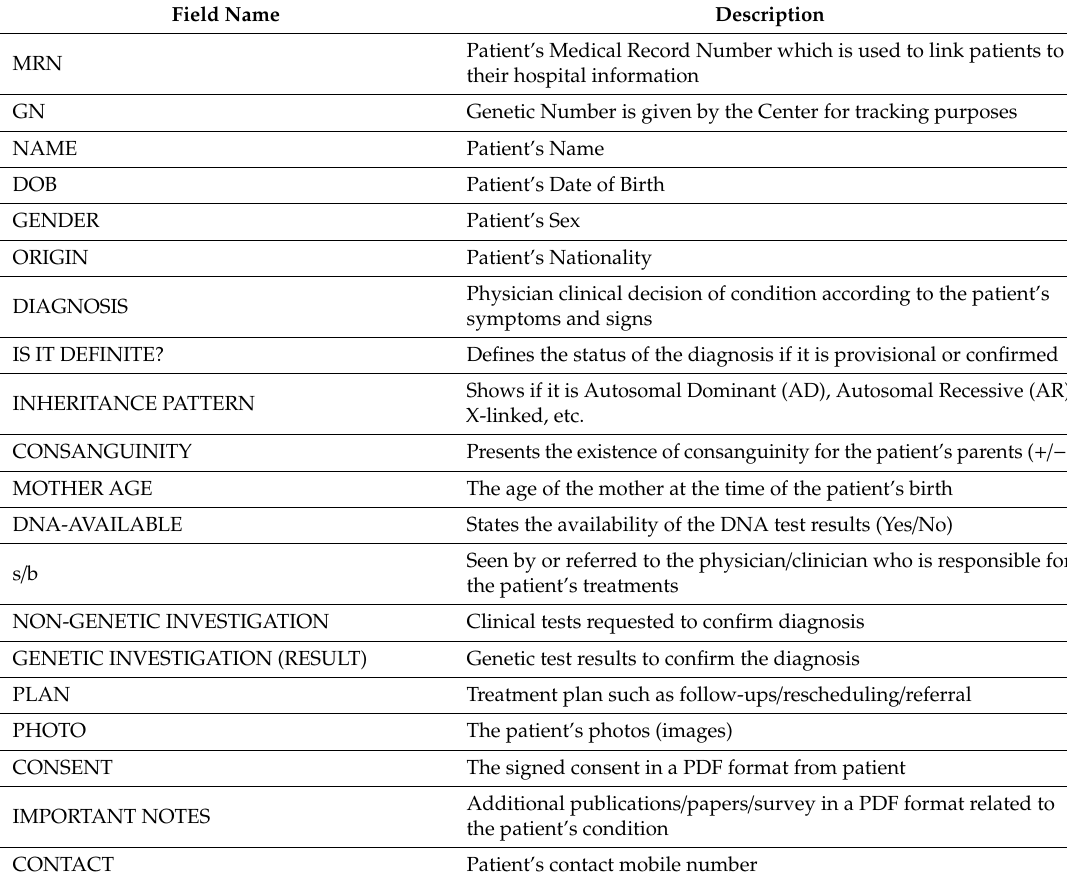
Table 1. The fields appeared in the Excel file used for data collection of clinical diagnosis process.